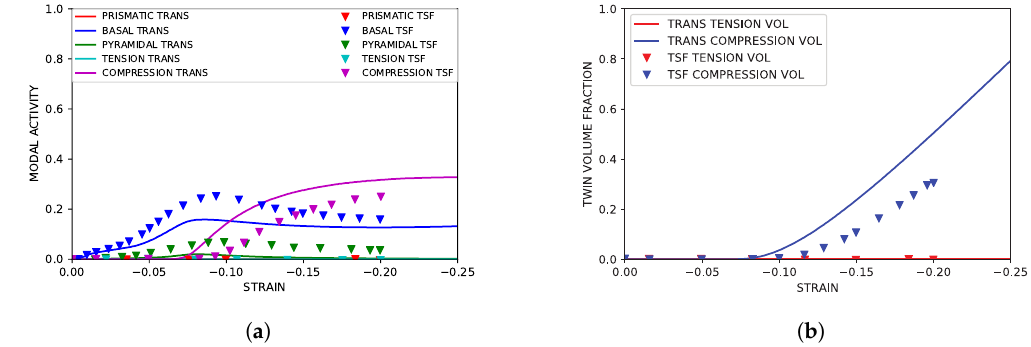
Figure 8. Simulated twin slip and secondary twinning activity under IPC compression compared to simulated results from Oppedal et al. [14]. ( a ) Simulated modal contributions to strain vs. strain. ( b ) Simulated twin volume growth vs.